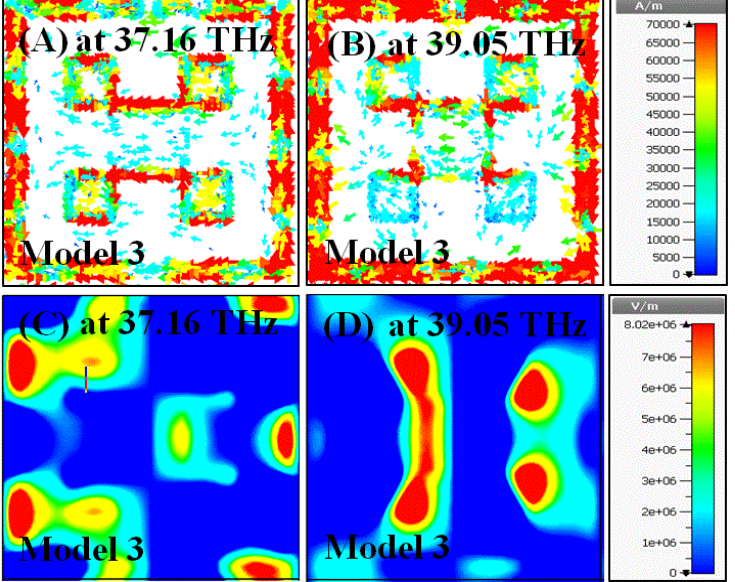
Figure 10. Simulated color map of the field distributions of Model 3 ( A ) surface current at 37.16 THz, ( B ) surface current at 39.05 THz, ( C ) electric field at 37.16 THz, ( D ) electric field at 39.05 THz.